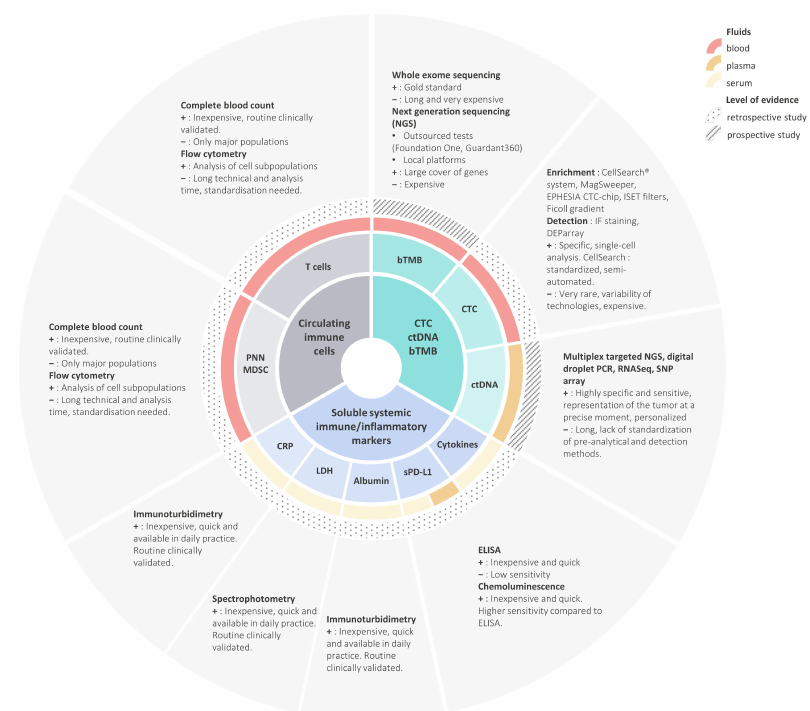
Figure 1. Main biomarkers and technical requirements. Fluids, level of evidence and pros ( + ) and cons ( − ) are represented on the third and subsequent layers. ELISA: enzyme-linked immuno assay. NGS: next generation sequencing. PCR: polymerase chain reaction. RNASeq: ribonucleic acid sequencing. SNP: single nucleotide